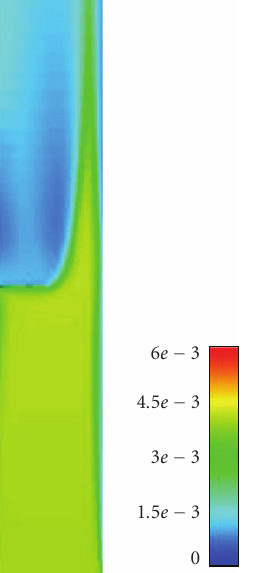
Figure 11: Neptune CFD result for mean Sauter bubble diameter (m), both breakup and coalescence being taken into account ( F B = F C = 1) run 074.